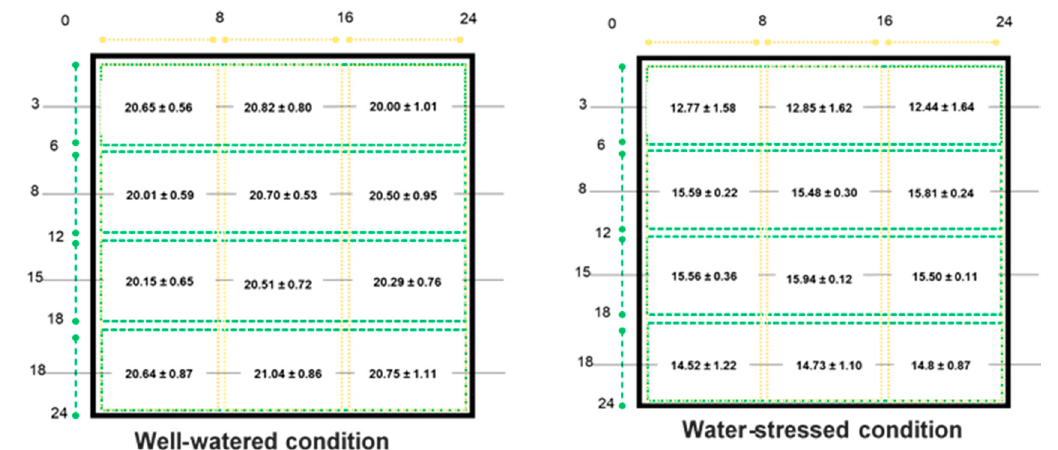
Figure A2. Diagram representing soil sampling from 12 squares a minirhizotron (24.5 × 24.5 × 2.5) cm. Values of volumetric soil water content (%) (mean ( n = 3) ± standard error).